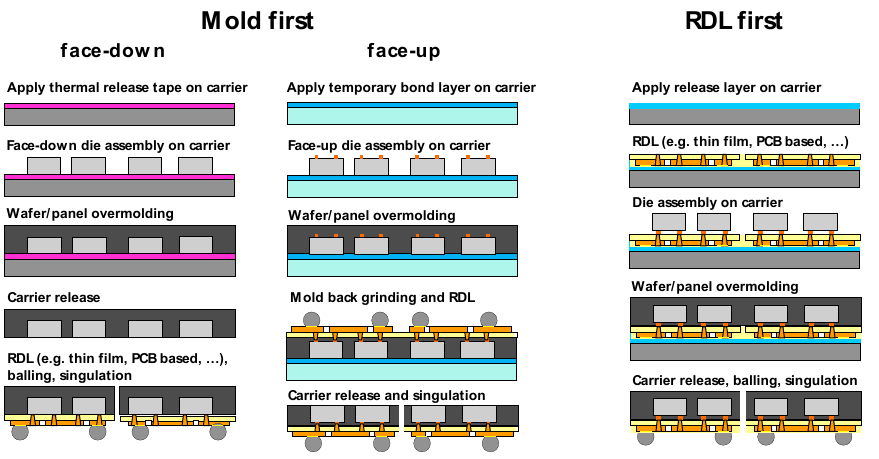
Figure 2. Fan-out wafer / panel level packaging process flow options.